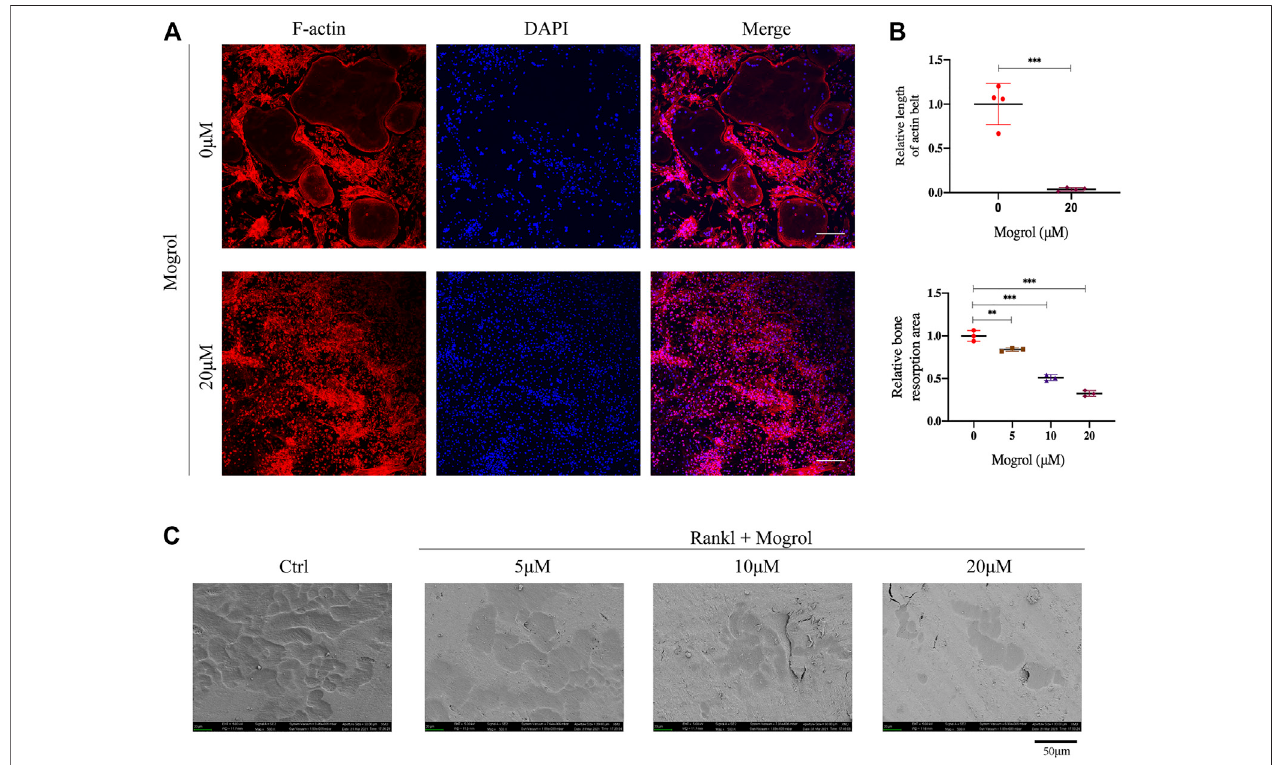
FIGURE3| Mogrolinhibitedtheformationofthepodosomalbeltandboneresorption. (A) BMMswerecultivatedwith(orwithout)20 μ Mmogrolwithstimulationof 30 ng/mlRANKL.After5 days,rhodamine-conjugatedphalloidinwasutilizedtostainthepodosomalbeltsofosteoclasts,andDAPIwereusedtolabeltheirnuclei( n =3), scale (B) Images ofthe bone resorptive area captured byscanning electron microscopy.( n = 3). (C) ImageJ software wasutilized tomeasure the resorption pit areaand F-actin belt length. bar = 100 μ m.